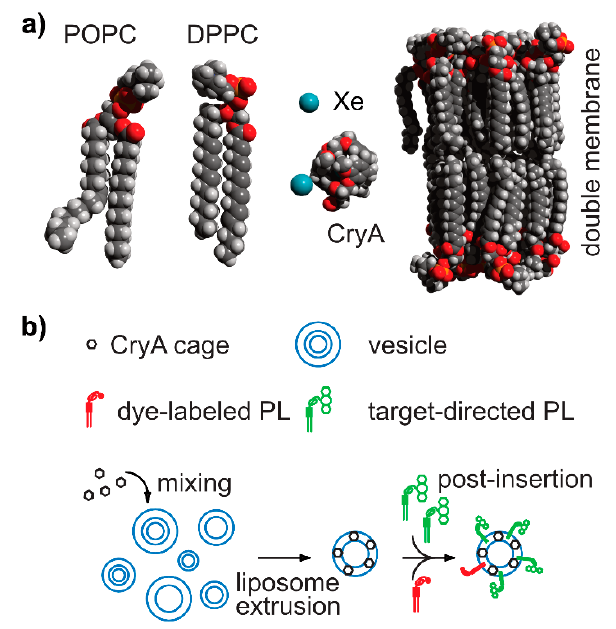
Figure 11. Lipid membrane components and functionalized liposome production for HyperCEST applications. ( a ) POPC with a kinked hydrocarbon chain yields more loosely packed membranes than DPPC with saturated, straight chains. A double membrane layer in comparison next to a lipophilic CryA cage. ( b ) Procedure for generating functionalized liposomes that carry CryA cages. Optional units are phospholipids with a dye unit or a binding moiety for a certain molecular target.